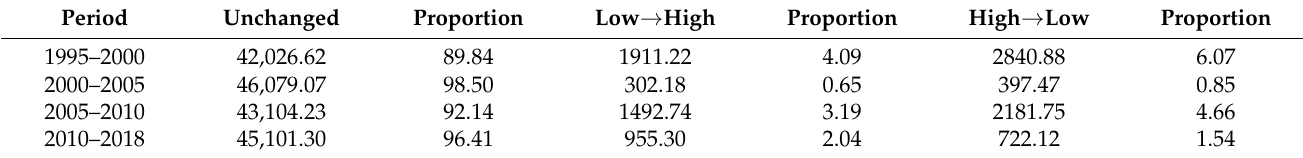
Figure 5. Spatial distribution of IESV change from 1995–2018. Table 6. Area of IESV change (km 2 ,